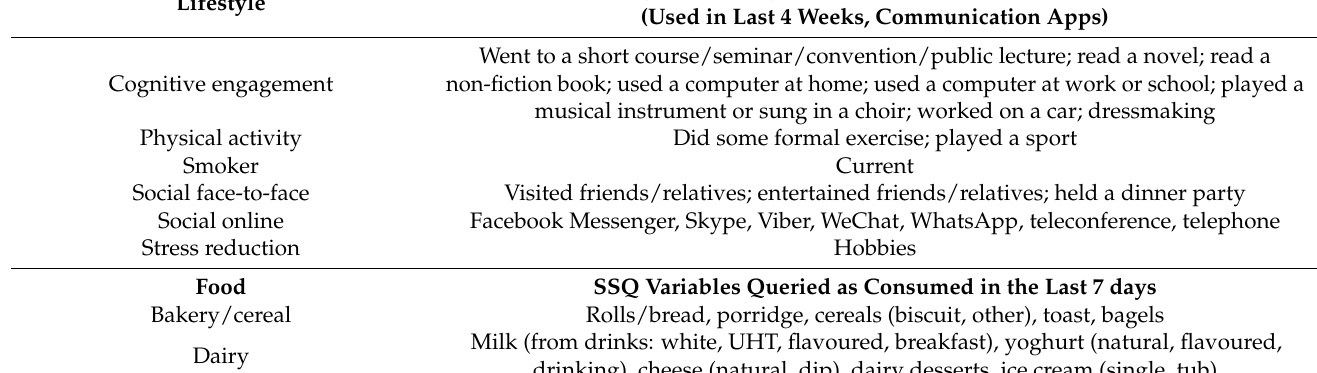
Table 1. Single Source Questionnaire (SSQ) variable inclusions for lifestyle behaviours and food and beverage categories.